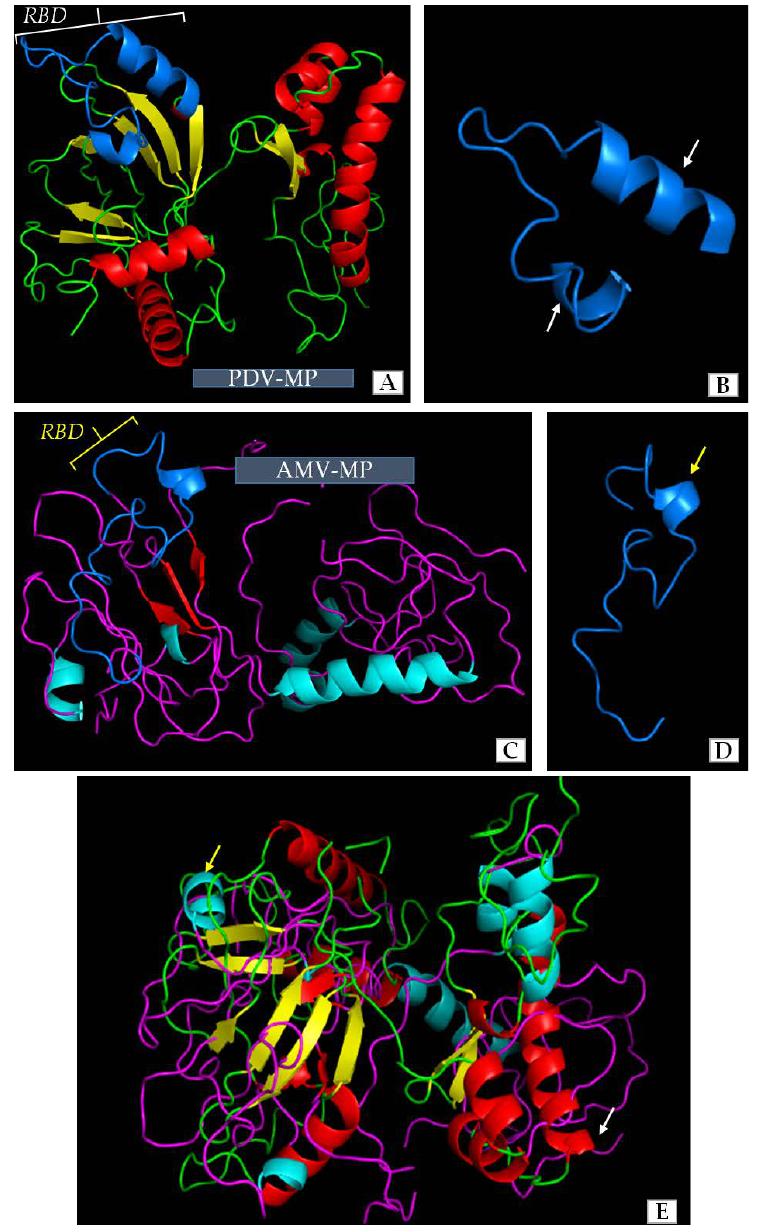
Figure 8. Three-dimensional (3D) model structures of the PDV movement protein (PDV-MP) and AMV movement protein (AMV-MP). ( A ) 3D model of PDV-MP structure. The colors show the particular elements of the secondary structure, as follows. Green indicates the fragments of straight polypeptide chain, red— α -helical fragments, yellow— β -card fragments, blue-RNA binding domain (RBD); ( B ) The blue color represents the RBD structure of PDV-MP, enlarged from ( A ). White arrows indicate two α -helical fragments of this domain; ( C ) 3D model of AMV-MP structure. The colors show the particular elements of the secondary structure as follows. Purple indicates the fragments of straight polypeptide chain, green— α -helical fragments, red— β -card fragments, blue—RNA binding domain (RBD); ( D ) The blue color show RBD structure of AMV-MP enlarged from ( C ). Yellow arrow specifies the α -helical fragment of this domain; ( E ) Overlaid of 3D models of PDV-MP and AMV-MP. Yellow and white arrows show AMV-MP and PDV-MP, respectively. The colors represent the particular elements as shown in ( A , C ) for PDV-MP and AMV-MP, respectively.